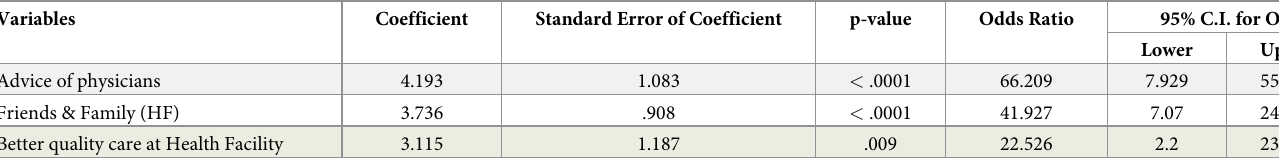
Table 5. Independent factors influencing of selecting country to receive